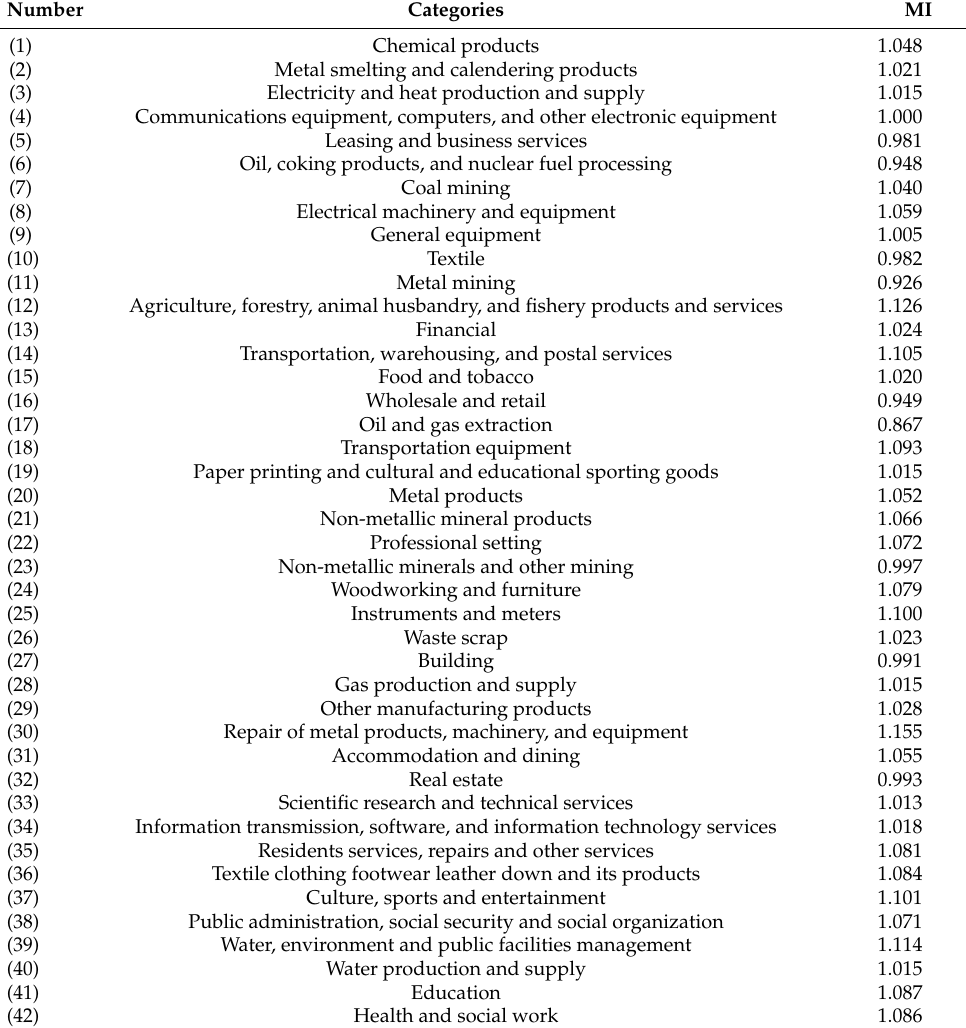
Table 1. Industry classification and average Malmquist index (MI) of the industrial